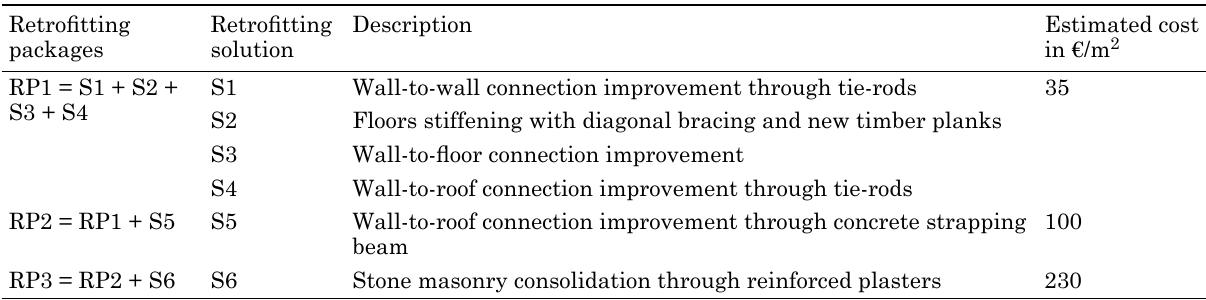
Table 2. Seismic retrofitting solutions adopted retrofitting